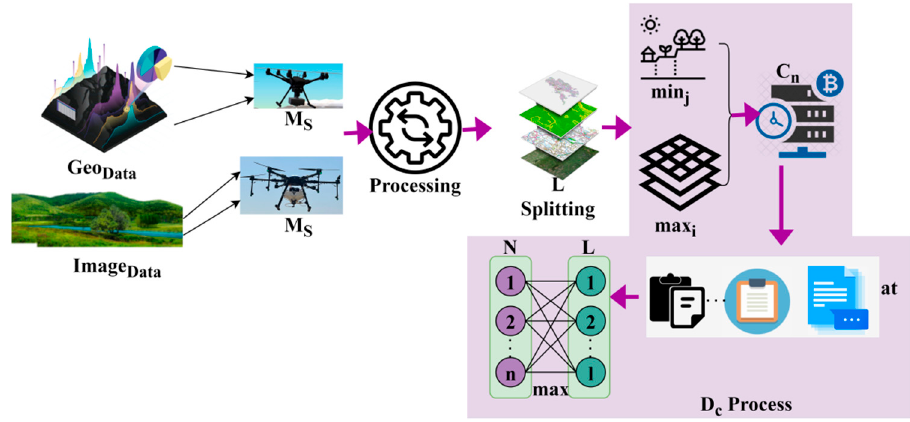
Figure 2. Analysis for D c